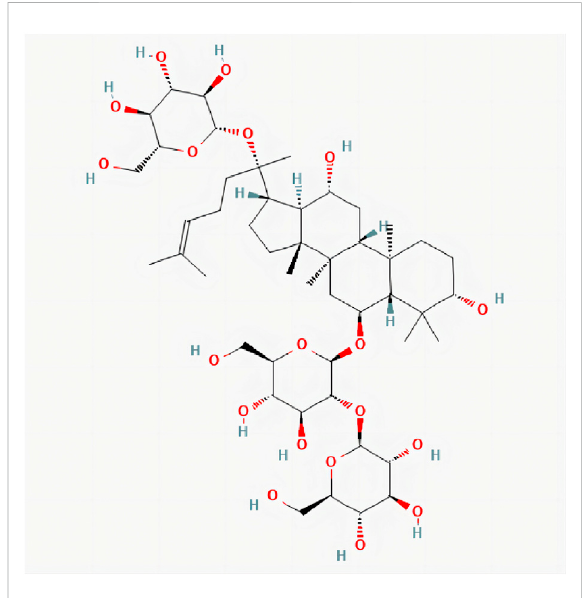
FIGURE 1 2D chemical structure of Ginsenoside Rd. Structure of Ginsenoside Rd cited from pubchem (pubchem CID, 24721561). The molecular formula is C 48 H 82 O 19